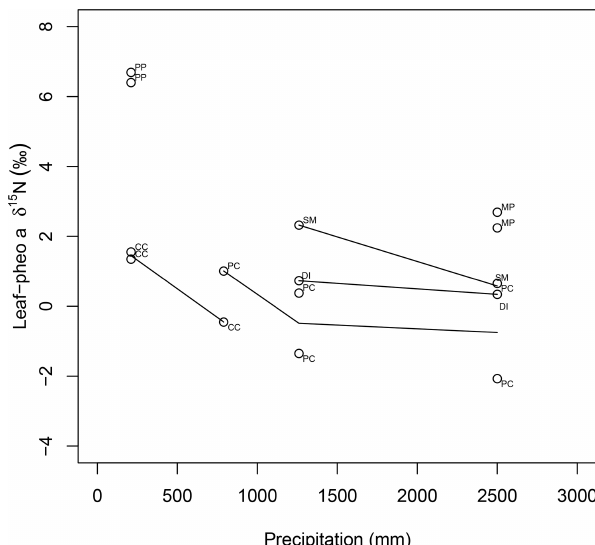
Table 3. Average, minimum, maximum, and range of intra-leaf δ 15 N offsets between pheo a and bulk ( 15 ε pheo − leaf ) for n mea- surements of each sampled species across all sites.